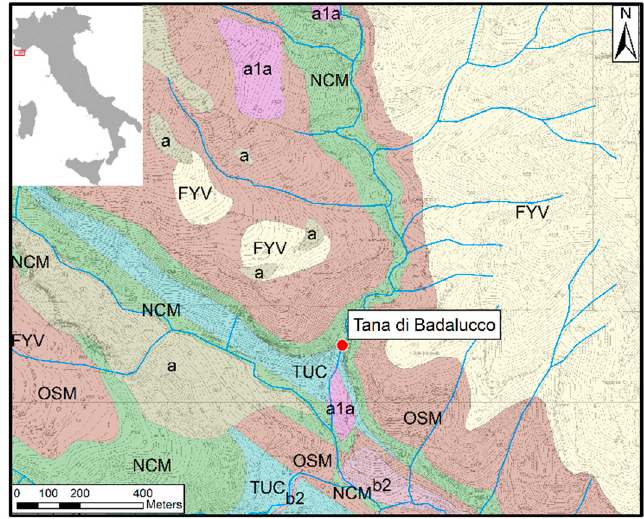
Figure 3. Geology of the study area. FYV: Ventimiglia flysch; NCM: Capo Mortola calcarenites formation; OSM: Olivetta S. Michele silty marls; TUC: Trucco’s marls and marly limestones formation.